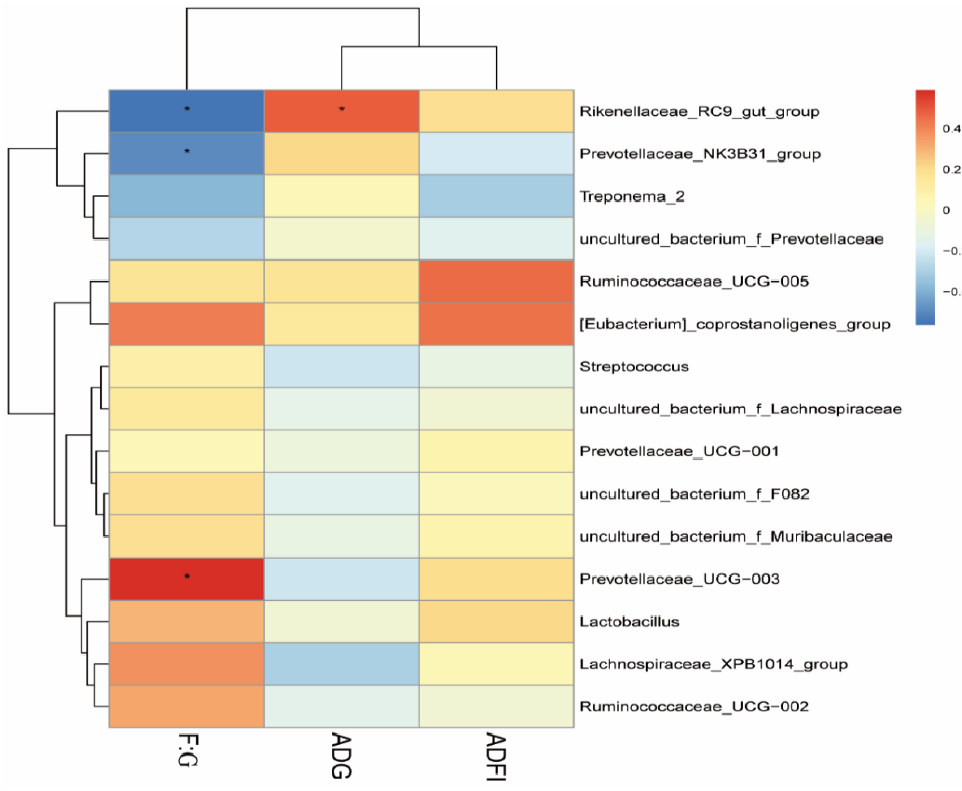
Figure 4. The Spearman correlation analysis of fecal microbial species at genus level with growth performance of pigs. Spearman correlation coefficients are represented by color ranging from red, positive correlation (0.6), to blue, negative correlation ( − 0.6). * indicates statistically signi fi cant difference ( p < 0.05). ADFI, average daily feed intake. ADG, average daily gain. F:G, feed − to − gain ratio.